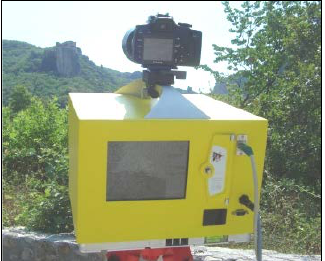
Figure 3. Laser Scanner with telephoto lens camera configuration